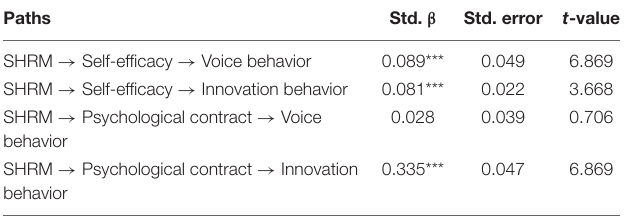
TABLE 3 | Indirect effect of structural model. Paths Std.